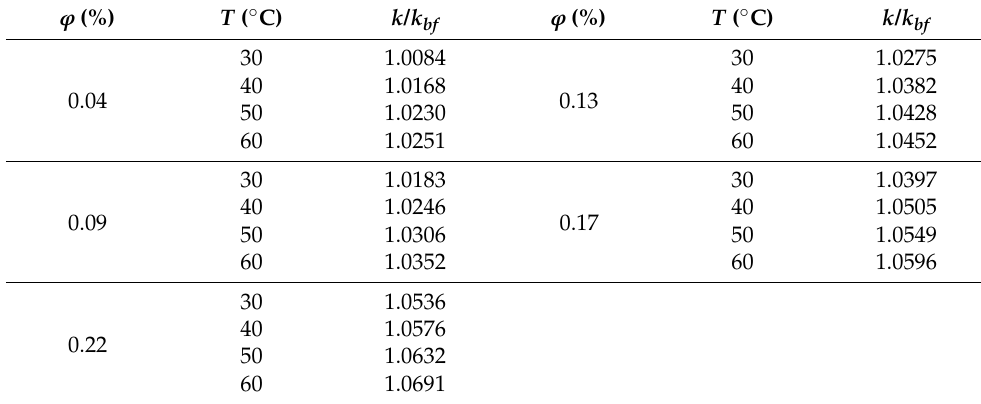
Table 3. Increase in thermal conductivity (SET-2).